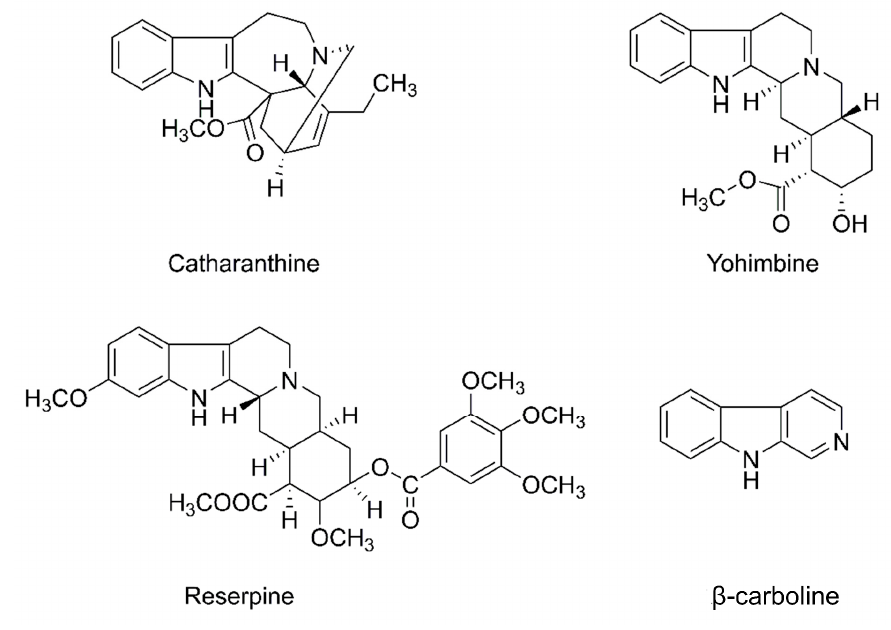
Figure 1. Structures of indole alkaloids used in this study.